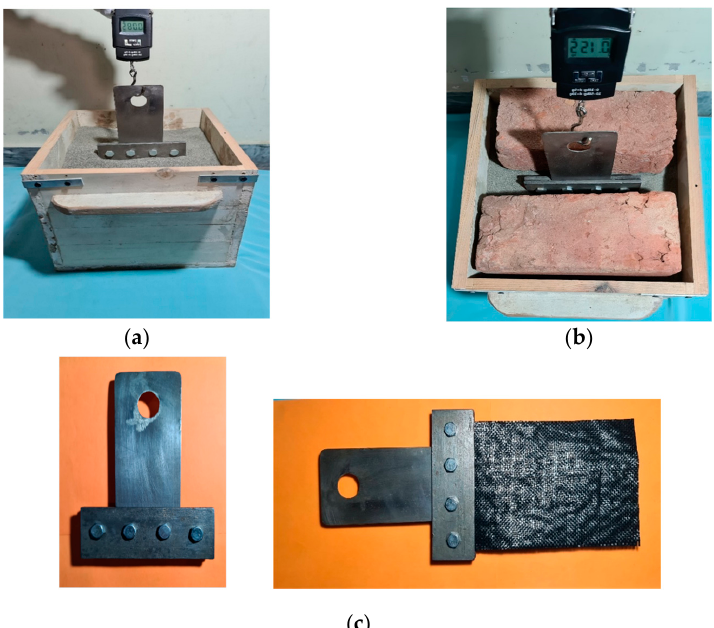
Figure 4. Assembled VPT setup ( a ) without surcharge and ( b ) with surcharge. ( c ) Clamp and hanger fabricated for holding the reinforcement and digital scale in VPT.